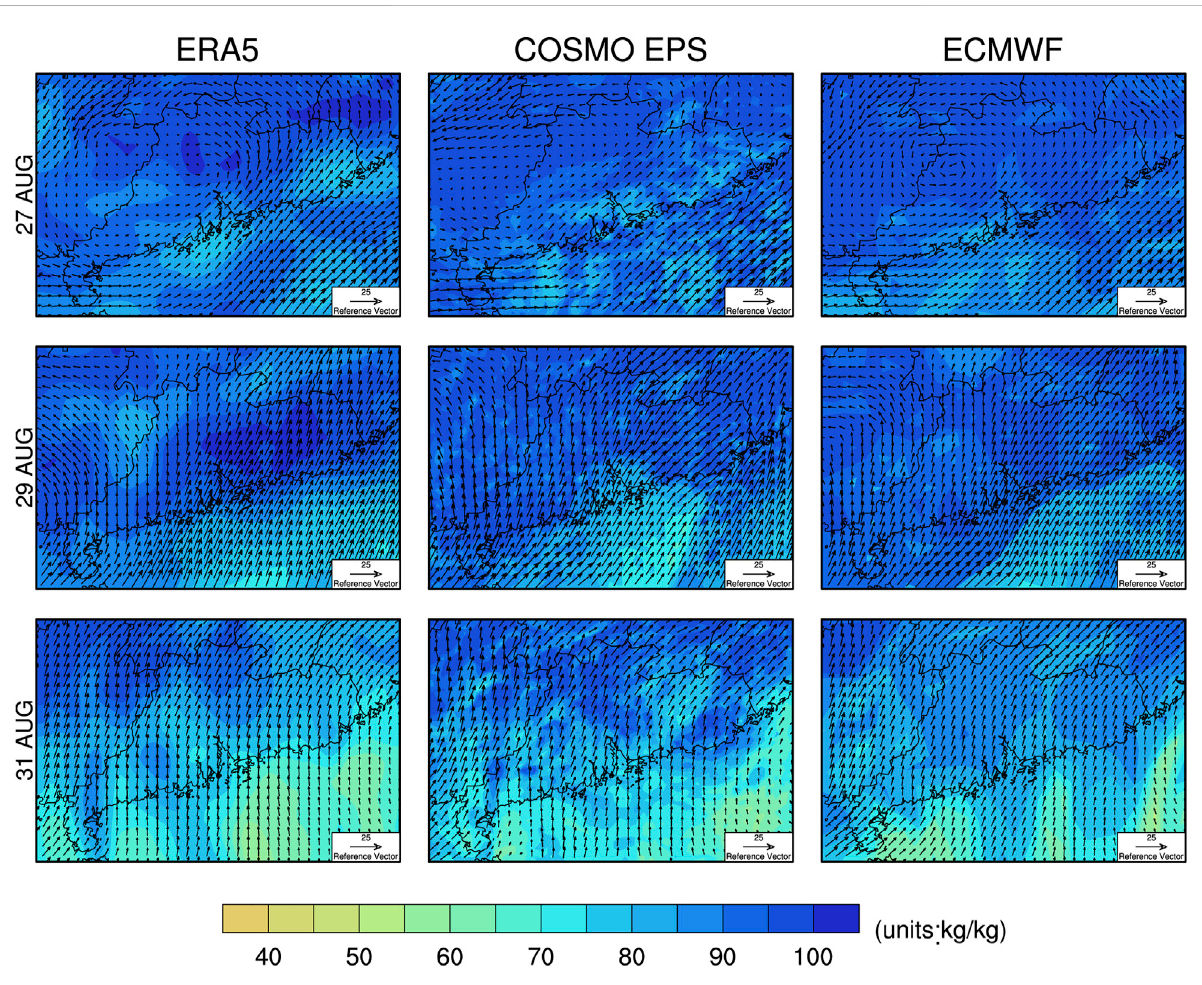
FIGURE 7 850 hPa wind vector and relative humidity (contour, unit: %) obtained from the observations, ensemble median forecasts of COSMO EPS, and deterministic forecasts of ECMWF at 18 UTC on 27, 29, and 31 August 2018.